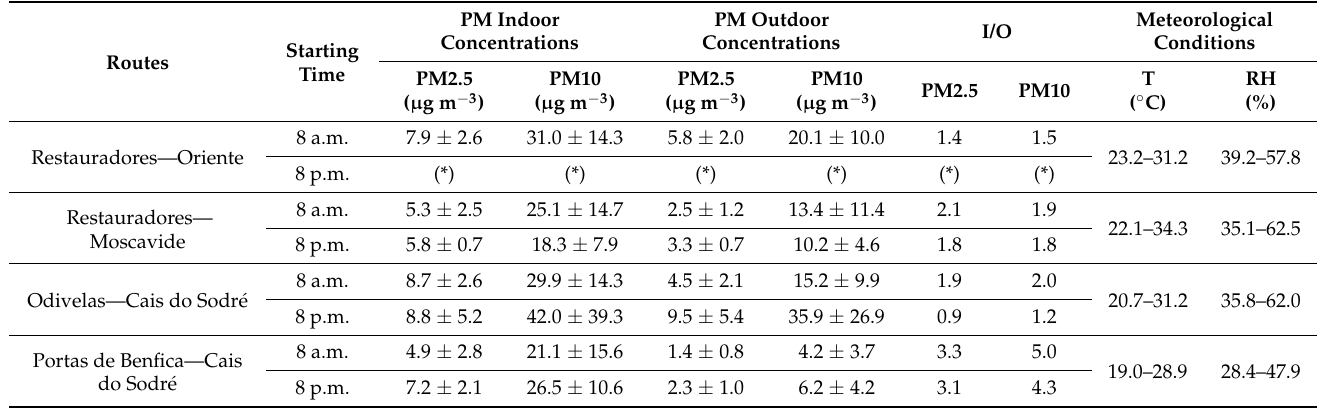
Table 2. Indoor and outdoor PM concentrations (average ± standard deviation) derived I/O ratios for the bus routes analyzed and the range of variation of the meteorological conditions (namely T and